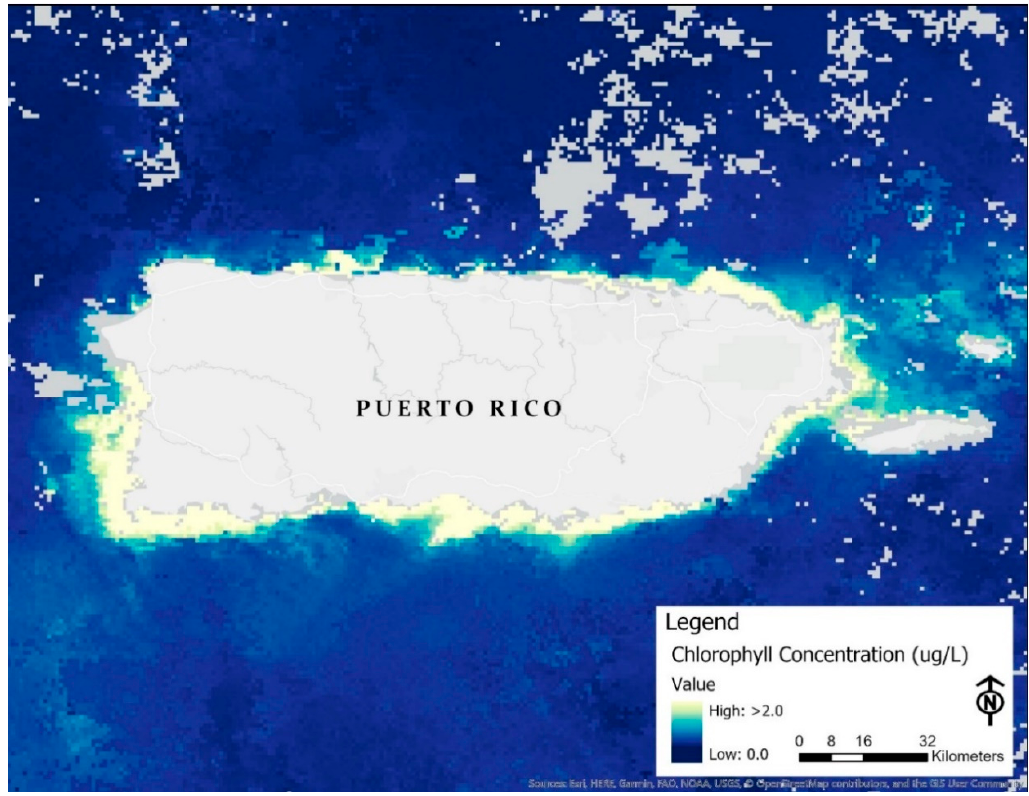
Figure 2. VIIRS satellite map of monthly mean chlorophyll- a (Chl- a ) concentration during September 2017.